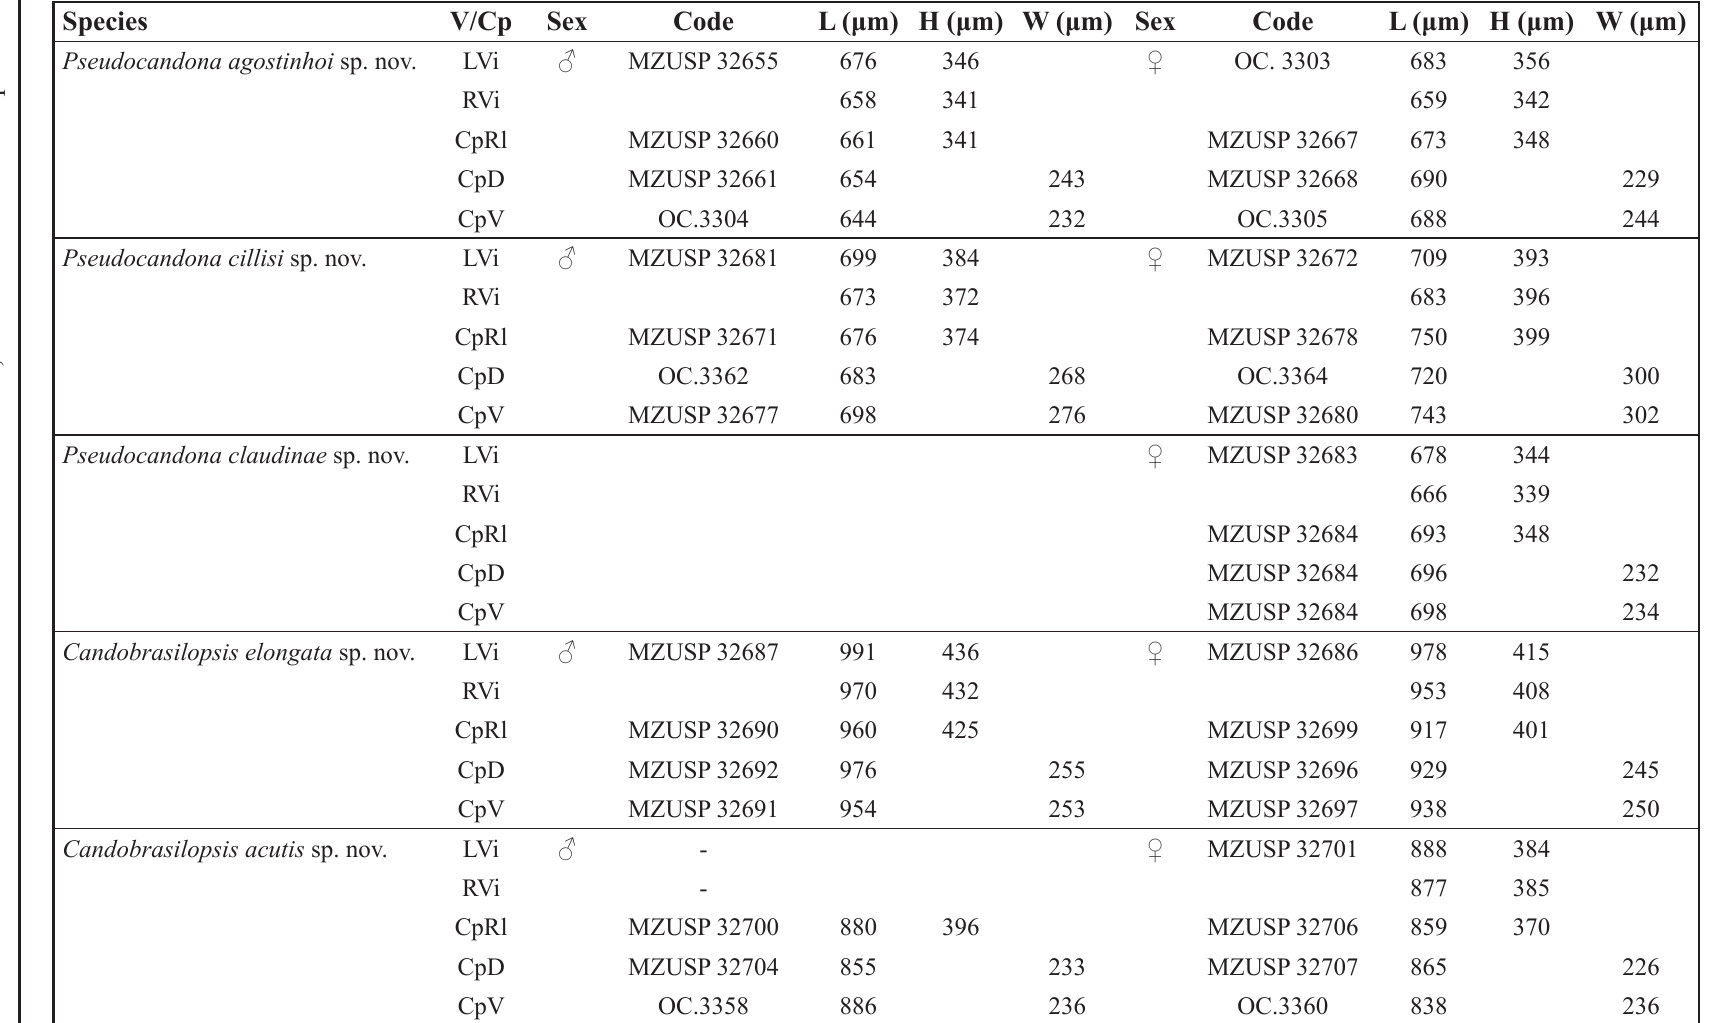
Table 3. Measurements of specimens of the three new species of Pseudocandona and two new species of Candobrasilopsis described in the present